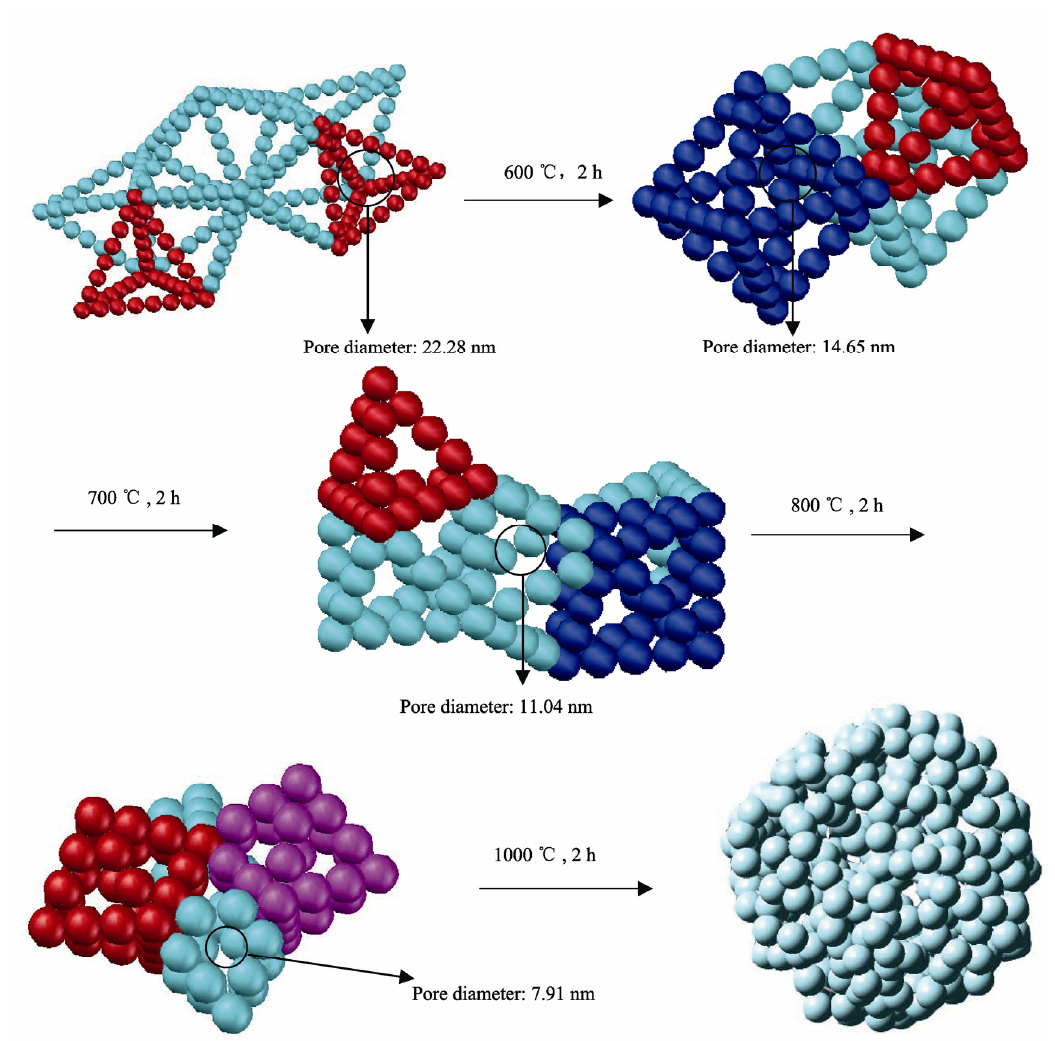
Fig. 9 Models of the transformation mechanism of pore structure during heat treatment.